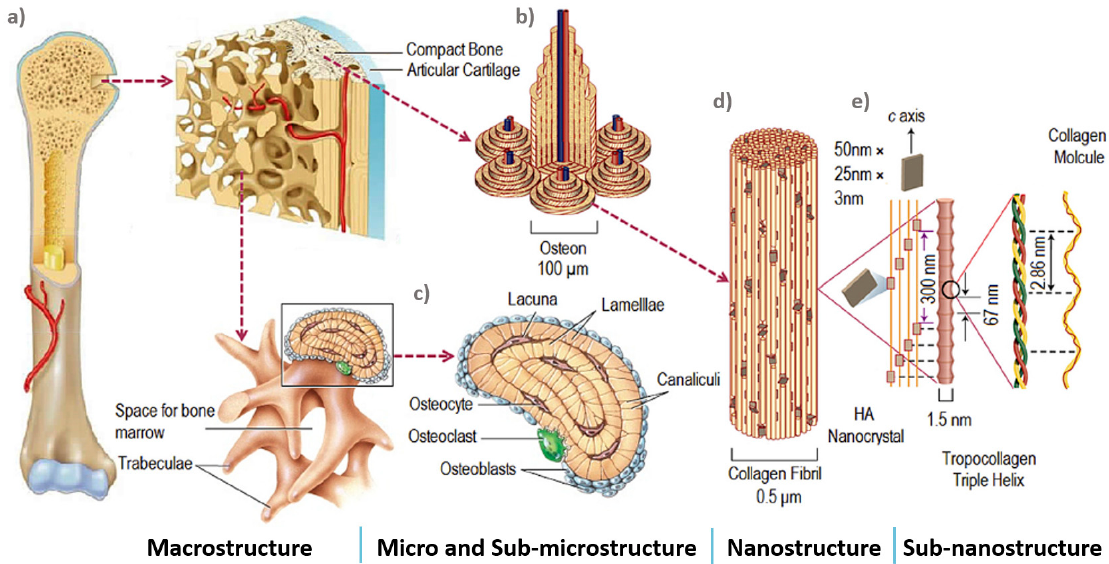
Figure 3. Hierarchical structural organization of bone: ( a ) cortical and cancellous bone; ( b ) osteons with Haversian systems; ( c ) lamellae; ( d ) collagen fiber assemblies of collagen fibrils; ( e ) bone mineral crystals, collagen molecules, and non-collagenous proteins. Image reproduced from Ref [81].